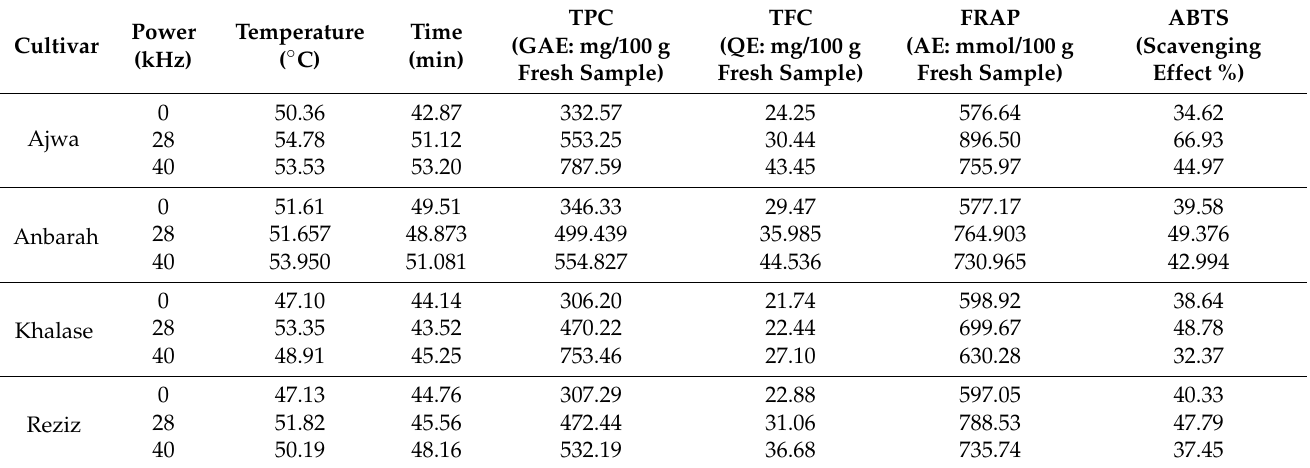
Table 3. Ideal predicted values of the factors (UAE frequency, temperature, and time) to get the maximum responses (TPC, TFC, FRAP, and ABTS) for each of the Date palm fruits’ cultivars (Agwa, Anbarah, Khalas, and Reziz) according to the surface plot analysis (see Figures